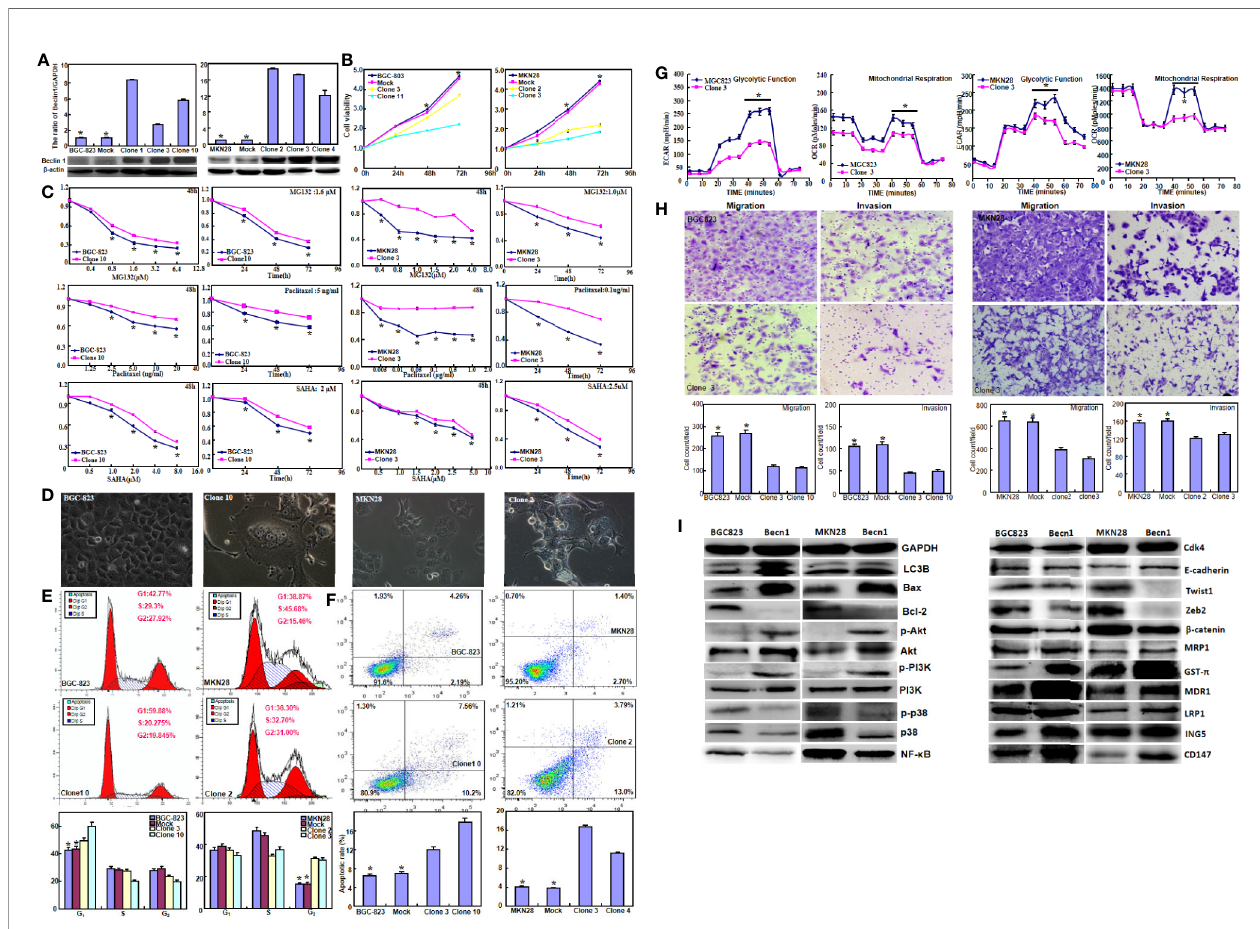
FIGURE 1 | The effects of Beclin 1 expression on aggressiveness of gastric cancer cells. Beclin 1 expression in BGC-823 and MKN28 cells was examined after transfection with pcDNA3.1- Becn1 by real-time RT-PCR and Western blot (A) . The transfectants showed a decrease in growth (B) and chemosensitivity to MG132, Paclitaxel and SAHA (C) in comparison with the control or mock. After Becn1 was overexpressed, the morphological appearance was observed under microscope (D) . Flow cytometry showed that Beclin 1 expression induced the G 1 arrest of BGC-823 cells, but S arrest of MKN28 cells (E) . Apoptosis was increased by Beclin 1 overexpression, as evidenced by Annexin V assay (F) . Oxygen consumption and transwell assays were used to monitor the glucose metabolism, migration and invasion of gastric cancer cells respectively (G, H) . The phenotype-related proteins were screened by Western blot (I) . * P < 0.05, compared with the DErricodata ( Figure 6B , P <0.05). In TCGA data, Becn1 expression was higher in male than female cancer patients ( Figure 6C , P <0.05). According to Kaplan-Meier plotter, Becn1 expression was found to positively correlate with overall and progression-free survival rates of all cancer patients ( Figure 6D , P <0.05), even strati fi ed by Lauren ’ s classi fi cation, TNM staging and treatment ( Table 3 , P <0.05). Female, male, T2, T3, N1-N3, M1, M0 and Her-2-negative cancer patients with high Becn1 mRNA expression had a high overall survival rate than those with its low expression ( P <0.05), while it was the same for progression-free survival rate in the male, T2, T4, N1-3, N1, M0,